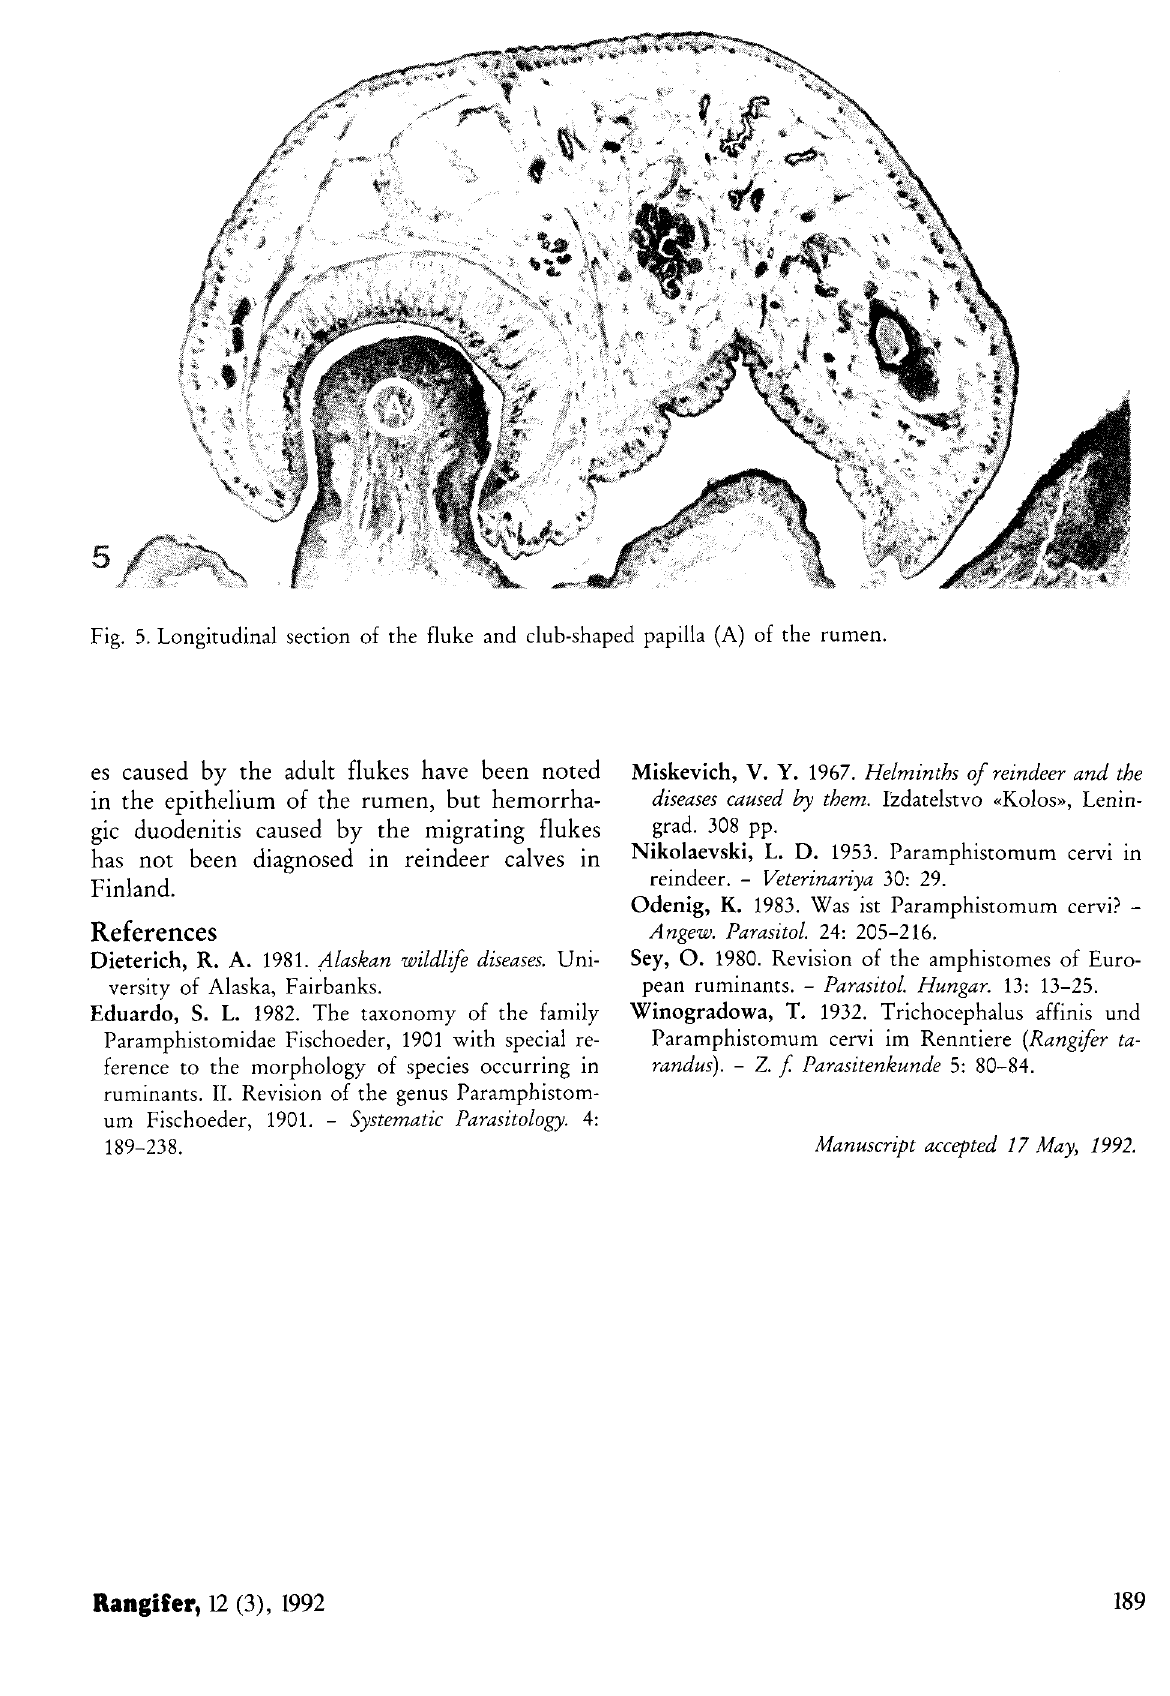
Fig. 5. Longitudinal section of the fluke and club-shaped papilla (A) of the rumen.